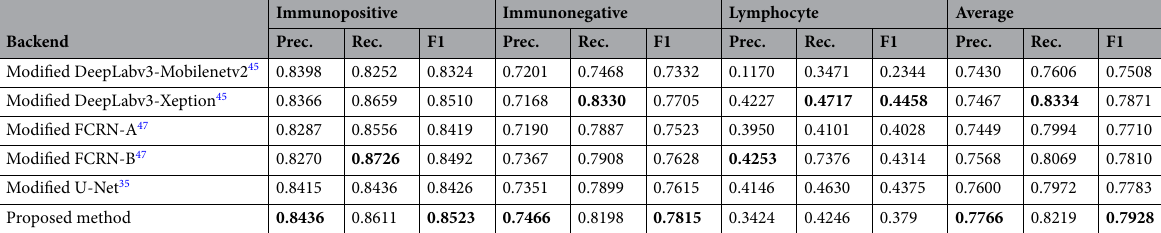
Table 3. Cell detection and classification results. Measurements on the test set in terms of precision (Prec.), recall (Rec.), and F1-score (F1.) reported based on different backends. Best results in each column have been shown in bold font.